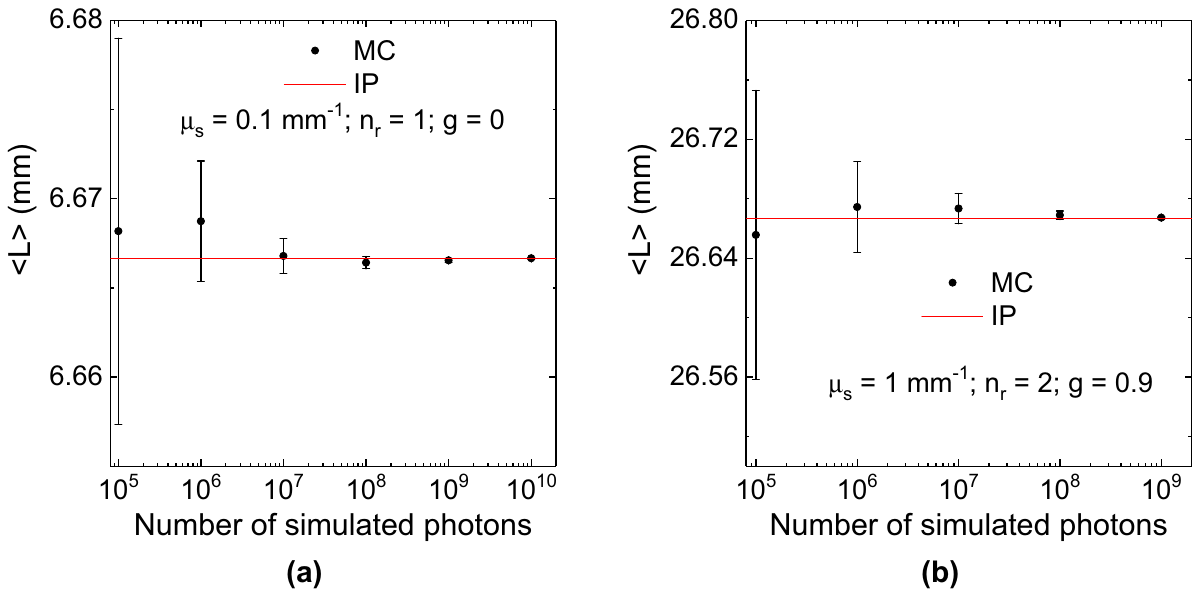
Figure 1. Homogeneous non-absorbing sphere of radius r 1 0 , whilst figure ( b ) pertains to a scattering coefficient µ 1 and g coefficient µ s = 0.1 mm − , n r = = 0.9 . The error bar is the standard error, i.e., the standard deviation of 2 and g n r = = numbers of simulated